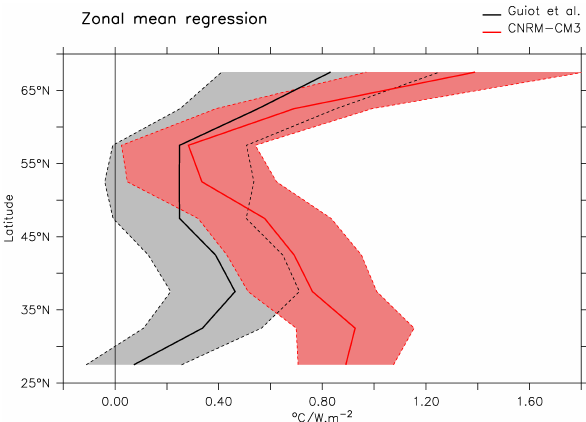
Fig. 4. Regression of the zonal mean summer temperature over the Figure 4. Regression of the zonal mean summer temperature over the solar forcing, in black 2 solar forcing, in black for the reconstruction and in red for the sim- for the reconstruction and in red for the simulation. The dashed lines correspond to a two 3 ulation. The dashed lines correspond to a two standard deviation standard deviation error bar computed from the residual of the regression. 4 error bar computed from the residual of the